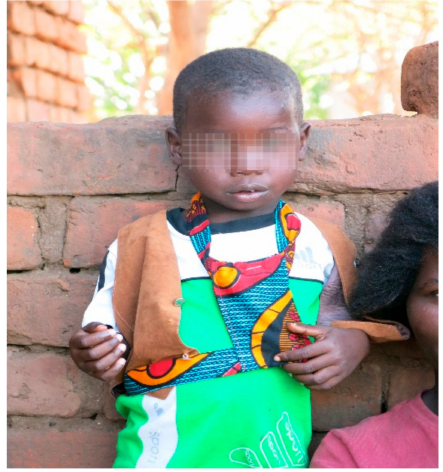
Figure 1. Picture of child wearing Lascar CO